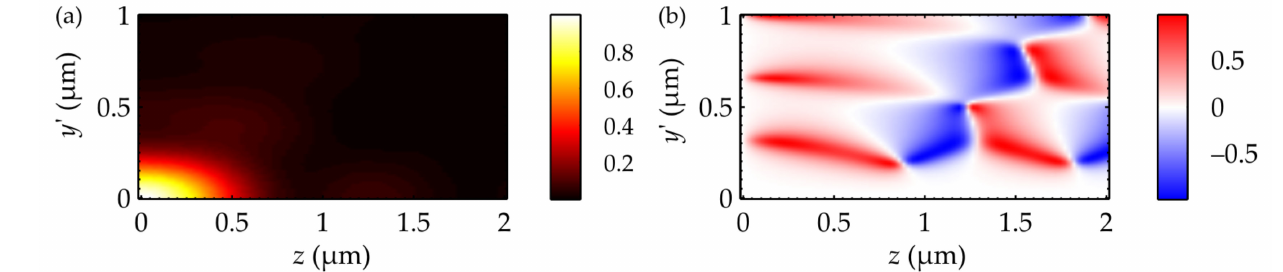
Figure 7. Distributions of the intensity (a) and of the third Stokes component (b) in the longitudinal plane yz along the z -axis (by an angle 45